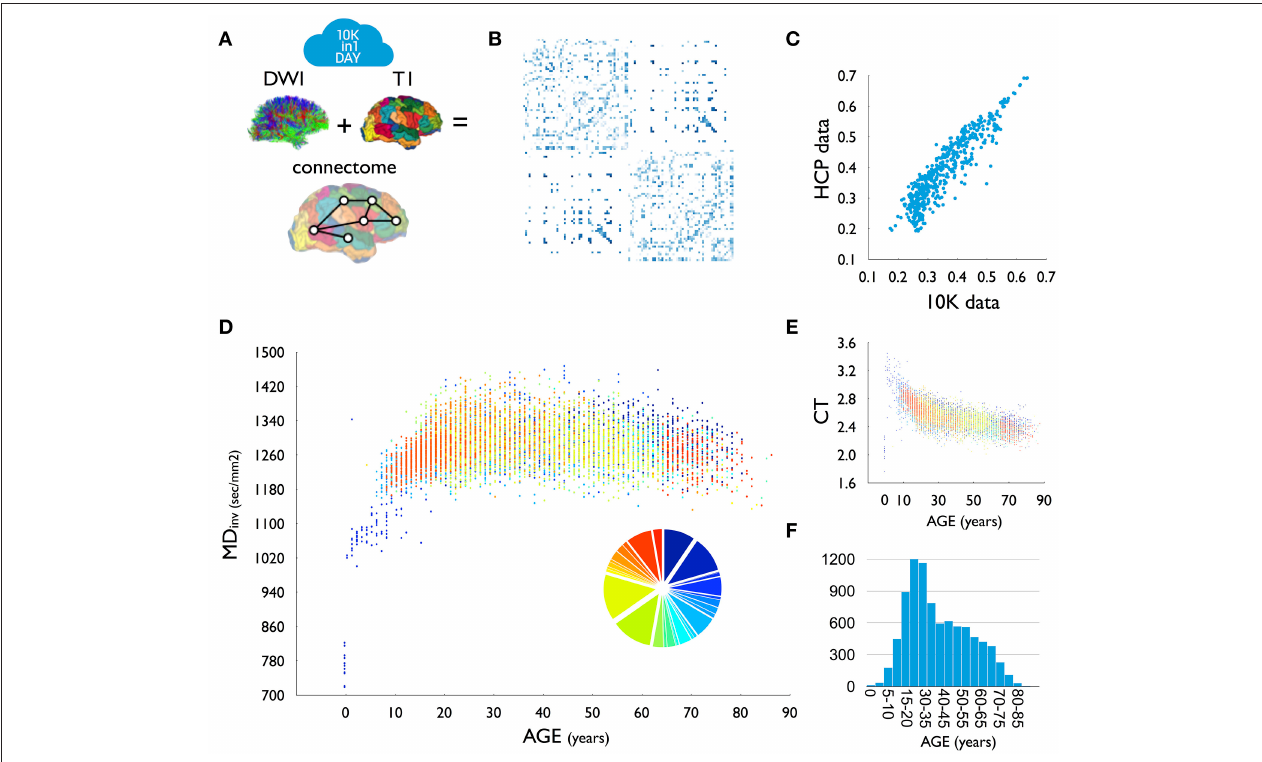
FIGURE 1 | (A) For each dataset, DWI tractography was combined with T1-based parcellation of cerebral brain regions to reconstruct a brain network. (B) Group-averaged (group threshold 33%) FA matrix of the 10K dataset. (C) High overlap ( r = 0.93) between group-averaged FA values as derived from high-resolution HCP data and the 10K dataset. (D) Relationship between age and average inverse mean diffusivity (MD, sec/mm2) across the 10K dataset. Colors indicate the different included datasets. Insert shows a pie diagram of the size of included datasets, color coded to set participation. One dataset (set_634413) was excluded from this plot, showing (across the age span) deviating FA (lower) and MD (higher) values than the other datasets (see methods). Due to the high total n, excluding this dataset did not change the relationship with age. (E) Relationship between age and average cortical thickness (CT). (F) Age distribution of the presented data as in (D,E) . T1, anatomical MRI; DWI, diffusion weighted imaging; CT, cortical